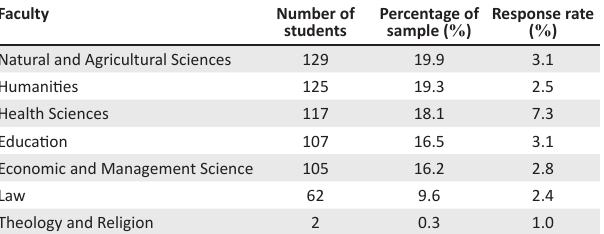
TABLE 1: Numbers of respondents from faculties at the University of the Free State ( n = 647).